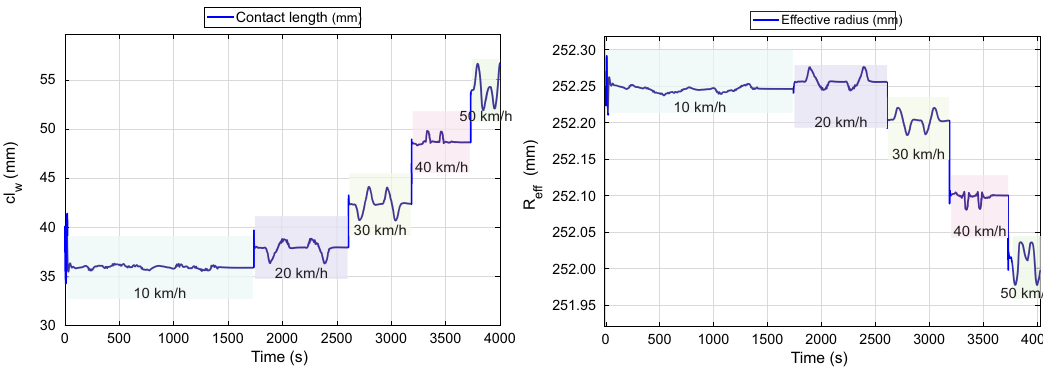
Figure 18. Results of fuzzy logic estimator, effective radius, R ef f , and contact length, cl w .